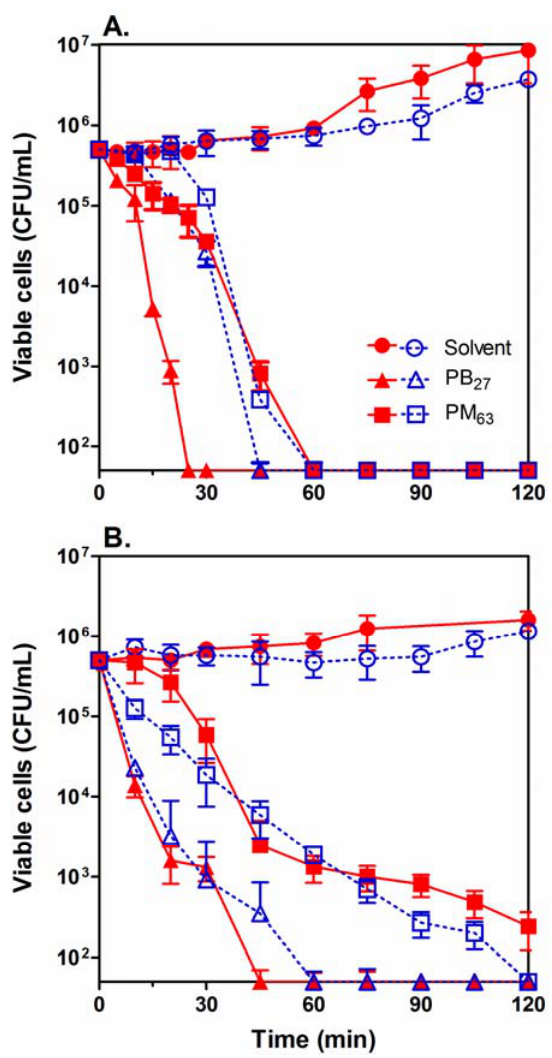
Figure 3. Kinetics of bactericidal activity of PMAs at 2 × MIC against E . coli (A) and S . aureus (B) subcultured from exponential ( red closed markers and solid lines ) and stationary ( blue open markers and dashed lines ) phase. The MICs of PB are 16 µg/mL 27 for both strains, and those of PM are 16 µg/mL for E . coli and 250 µg/mL for S. aureus . 63 Each point represents the mean of values from two separated experiments